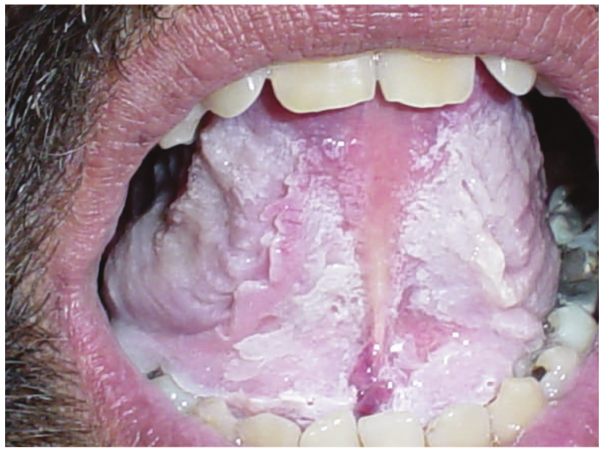
Figure 1 - Adherent white patch on ventral surface of tongue and floor of the mouth.